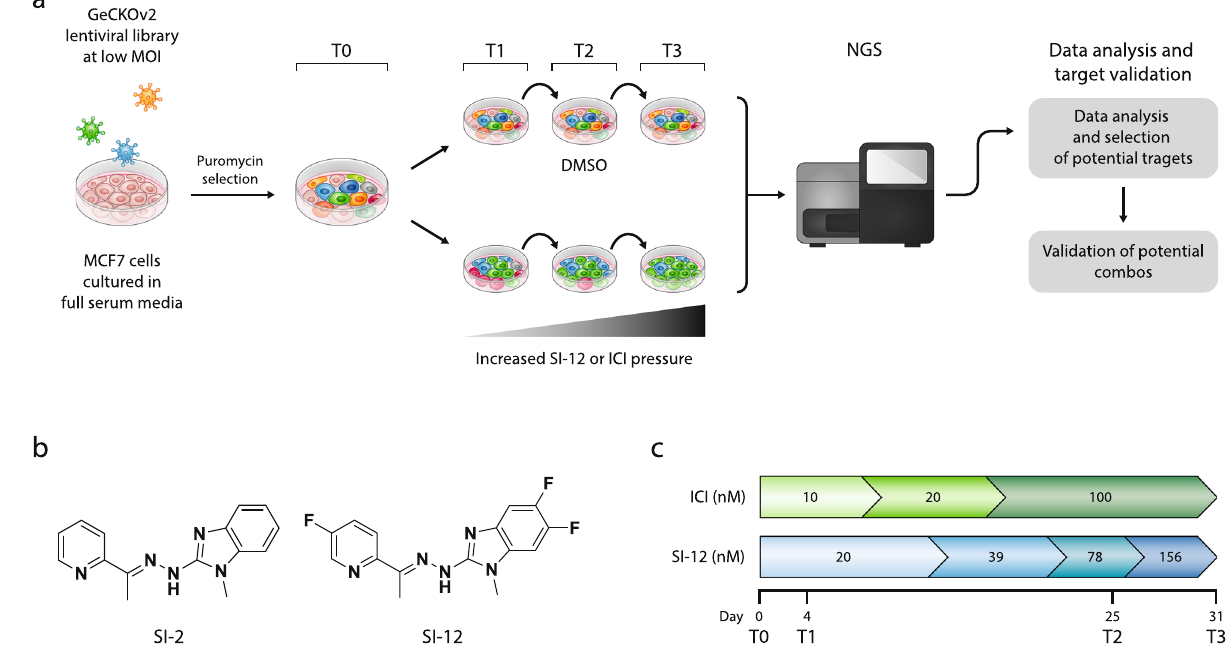
Fig. 1 Pooled CRISPR/Cas9 screening using the genome-wide single vector library GeCKOv2 in MCF-7 cells. a Schematic outline of pooled CRISPR/ Cas9 screens under increased pharmacological pressure of either SI-12 or ICI to identify genetic vulnerabilities for drug combinations. b Molecular structures of SRC-3 inhibitors SI-2 and SI-12. c Timeline of the screens. Increased drug-pressure was applied on the cells and gDNA was collected at three- time points, which was subsequently ampli fi ed by PCR at the bar-coded regions and then subjected to